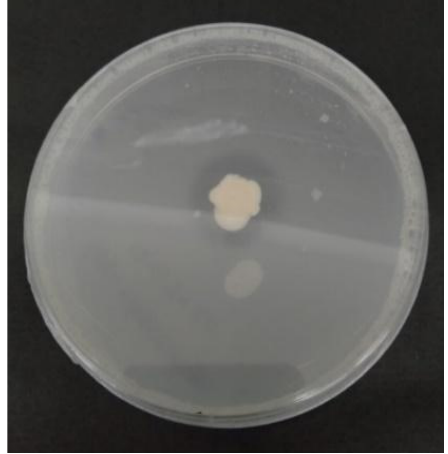
Figure 3. Halo zone on Pikovskaya agar indicating S. yanoikuyae SJTF8 phosphate solubilization.